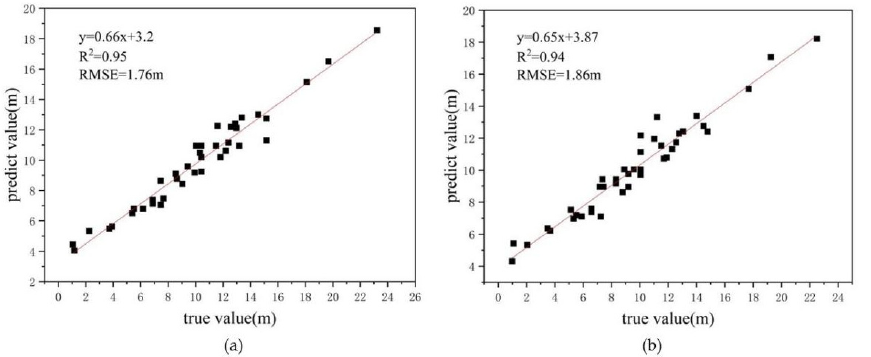
Figure 11. DEM differential interference method with random forest estimation of tree height pre- cision and fitting equation ( a ). Coherent amplitude method with random forest estimation of tree height precision and fitting equation ( b ).